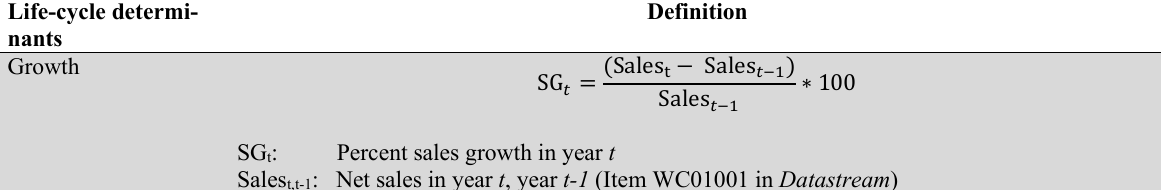
Determinants of life-cycle